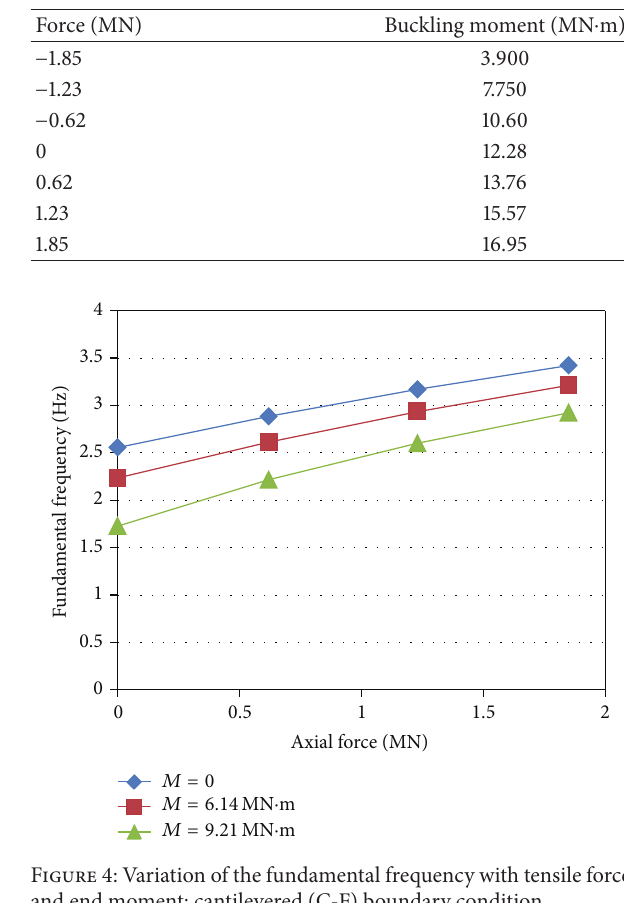
Table 6: Critical buckling end moment versus compressive force; cantilevered boundary condition.